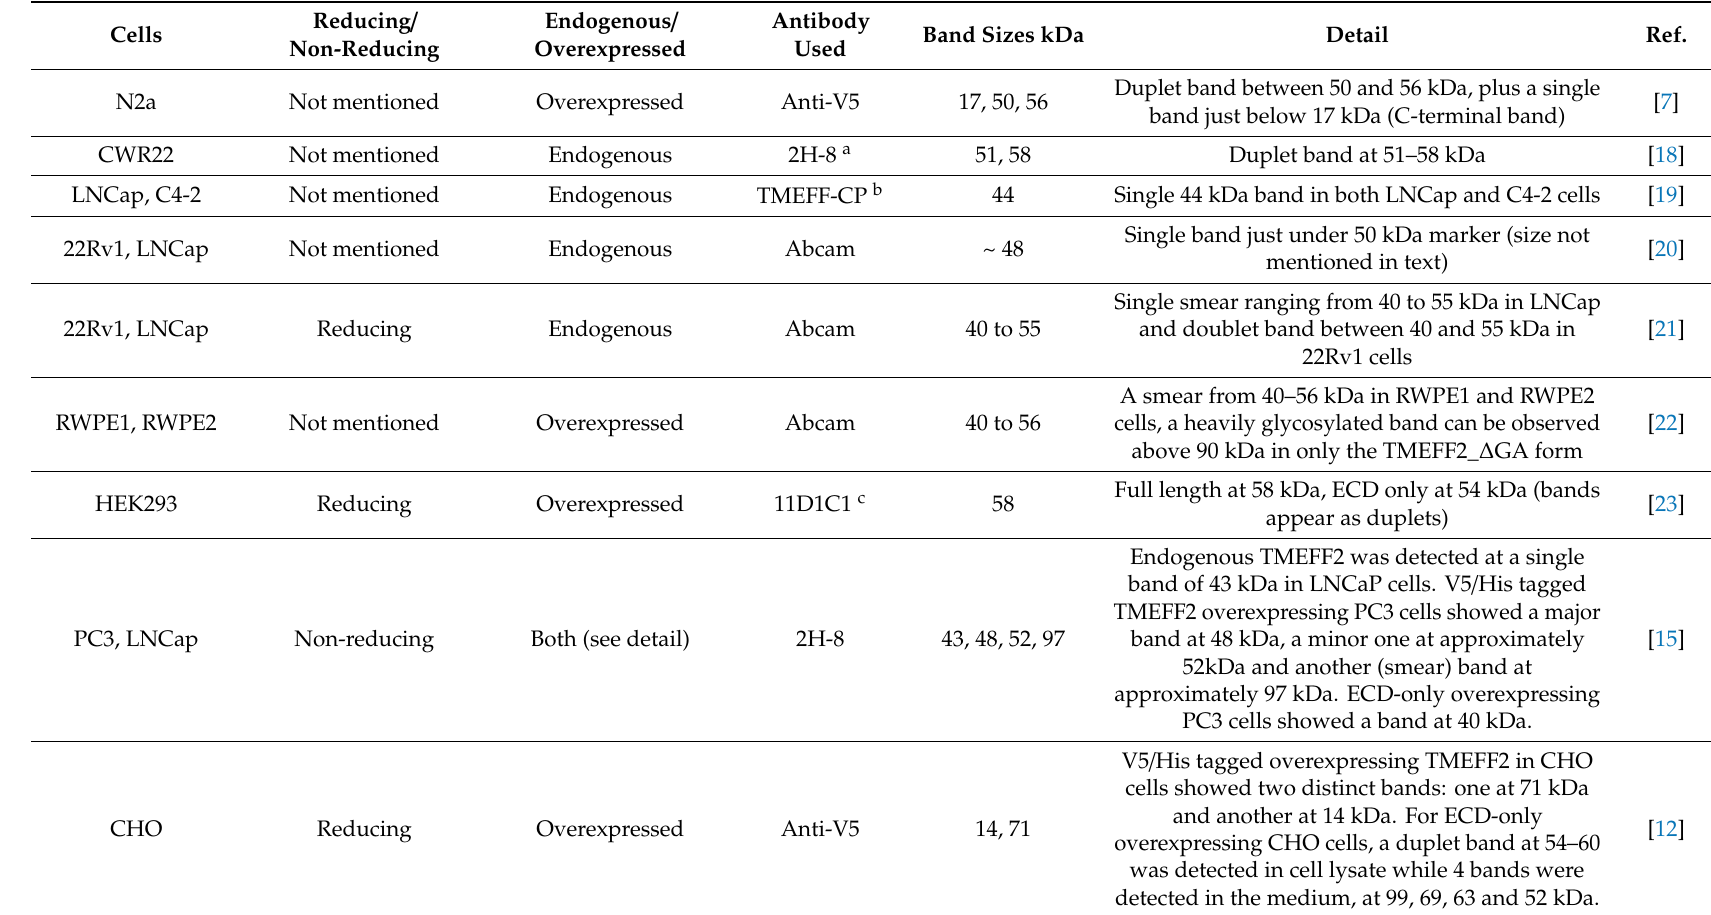
Table 1. TMEFF2 immunoblot